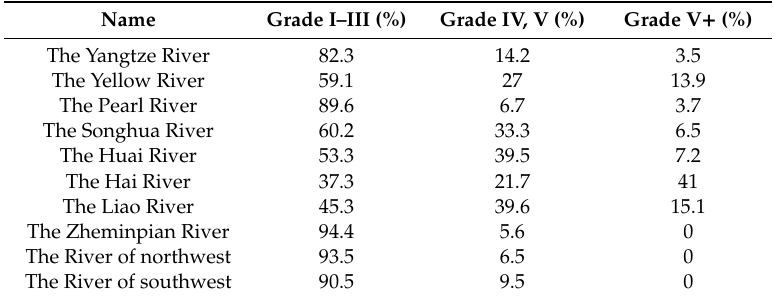
Figure 7. Wastewater discharge in China. (China Annual environmental statistics 2000–2015). Table 1. Water quality of major ten rivers of China in 2016 (China environmental state bulletin).